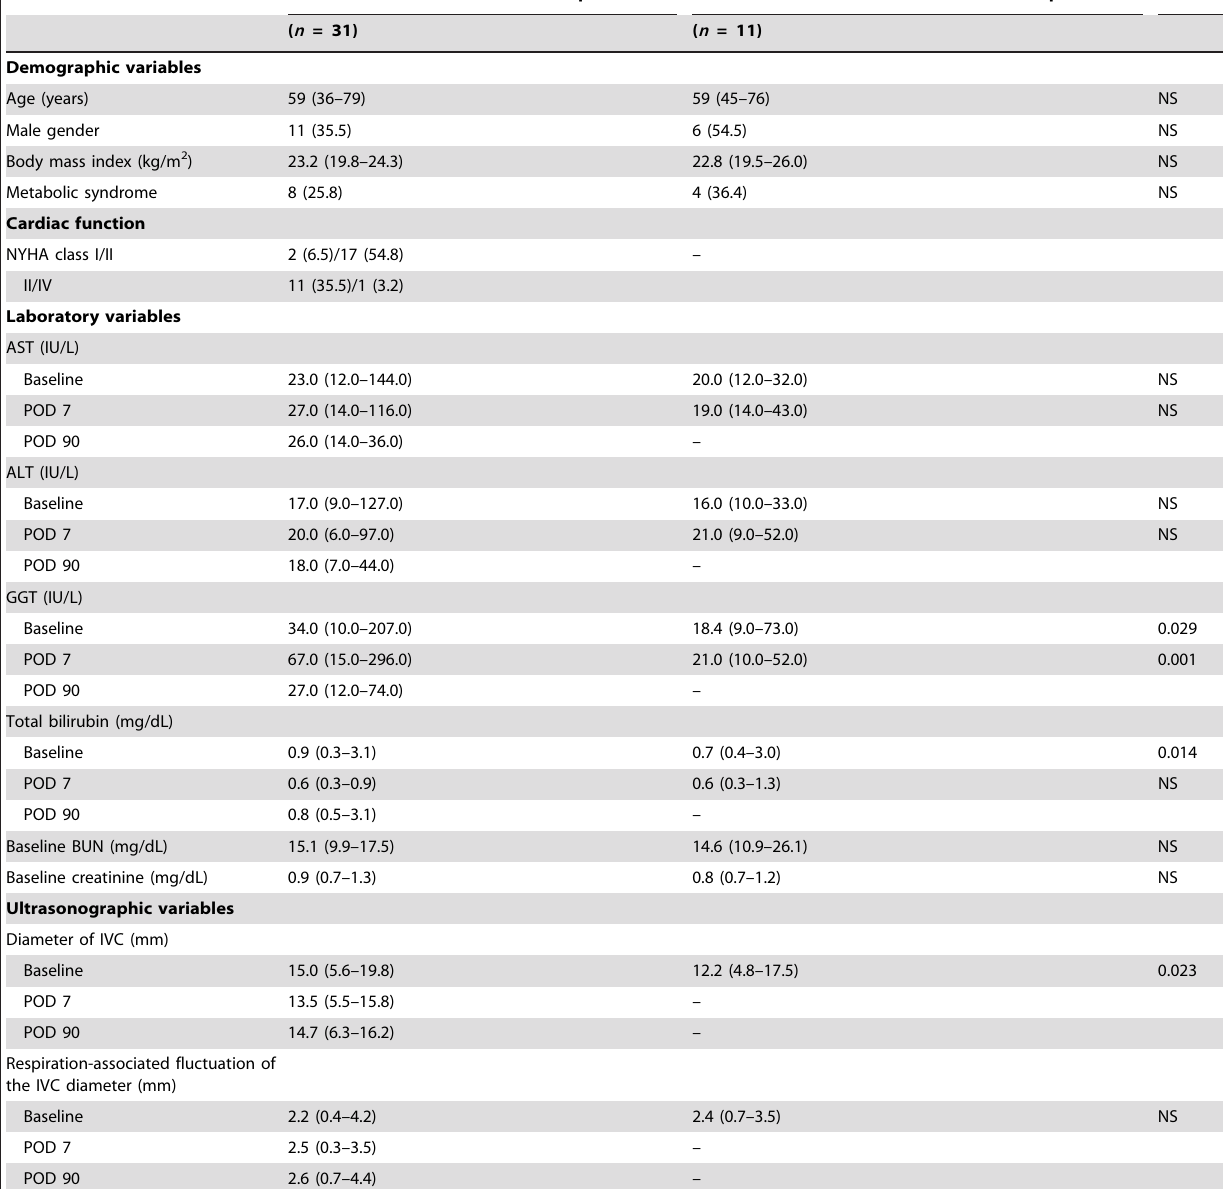
Patients who underwent a valve operation Patients who underwent a varicose vein